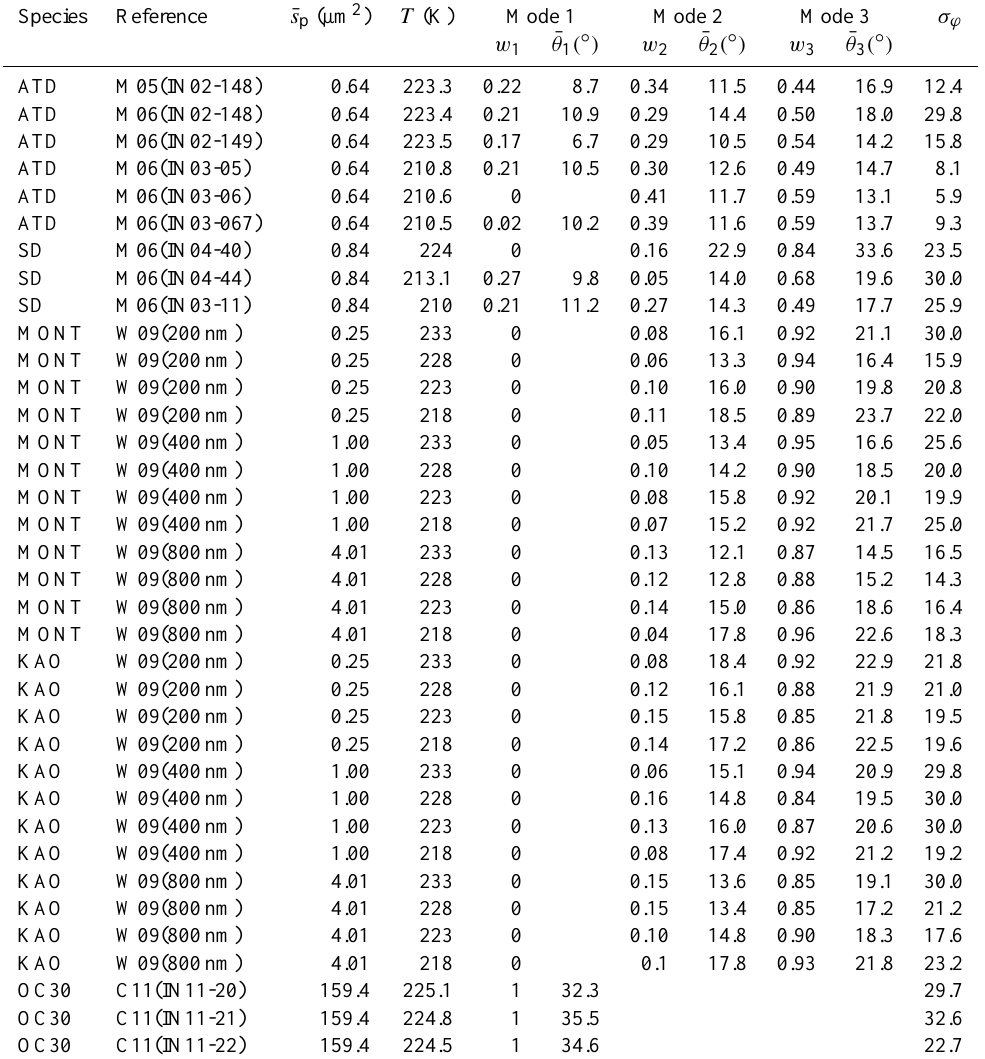
Table 2. Parameters of the nucleation spectra derived from the data reported by M¨ohler et al. (2006, M06), Welti et al. (2009, W09), and Crawford et al. (2011, C11); σ ϕ is assumed to be the same in all modes.